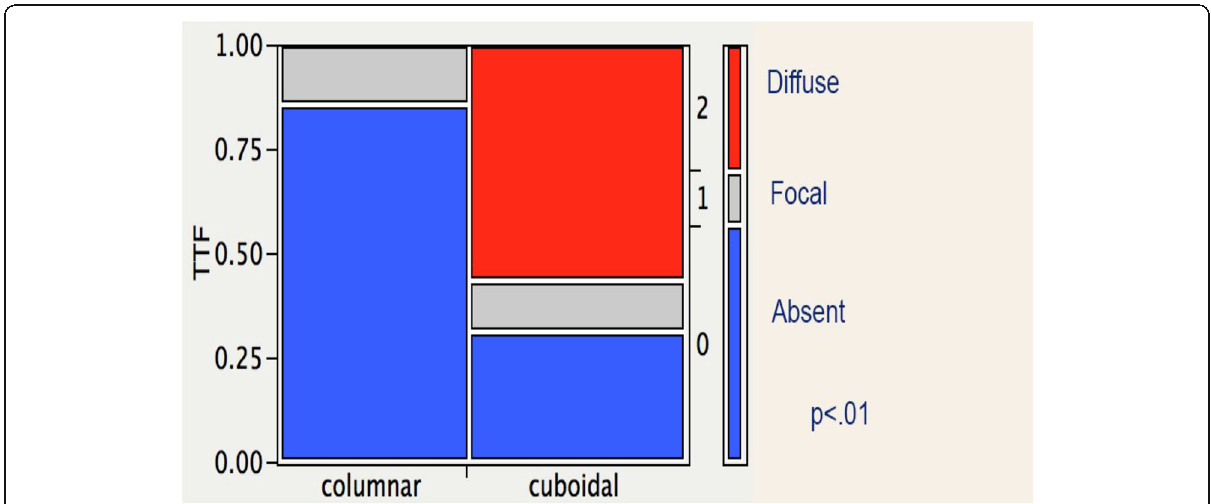
Fig. 4 TTF-1 immunoreactivity, extent compared to mucin cell